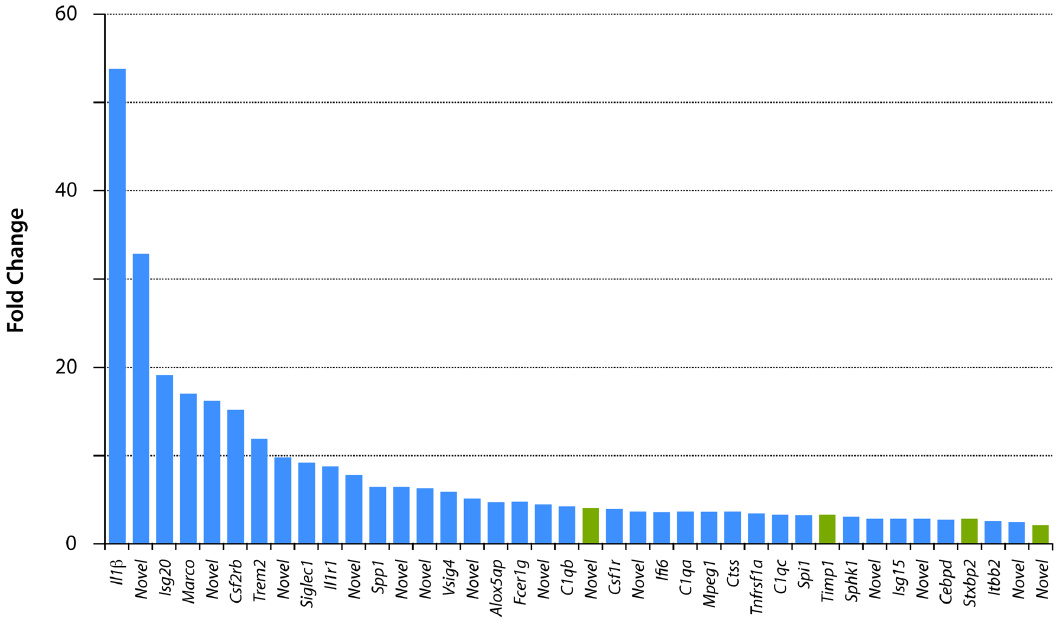
Figure 3. Changes in gene expression 24 h following spinal transection at P7. Only 40 genes changed their expression levels by $ 2 fold. All were upregulated. See Table S1 for gene descriptions and statistics. There were 12 ‘‘novel’’ genes; search of GO categories showed that these have immune/inflammatory properties. Note that only four of the genes in this figure (green bars) are not in the immune/inflammatory category (blue bars).